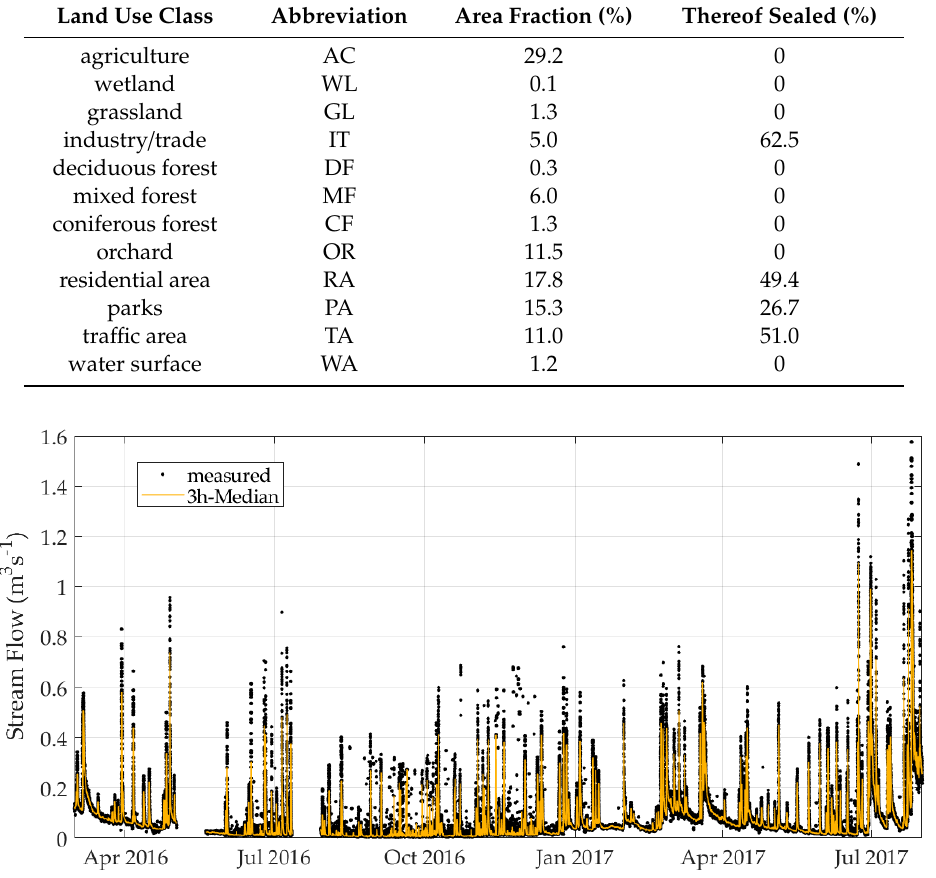
Figure 2. Measured stream flow and corresponding smoothed curve (3-h-median sliding interval) at the monitoring station “Autobahn” (AB).